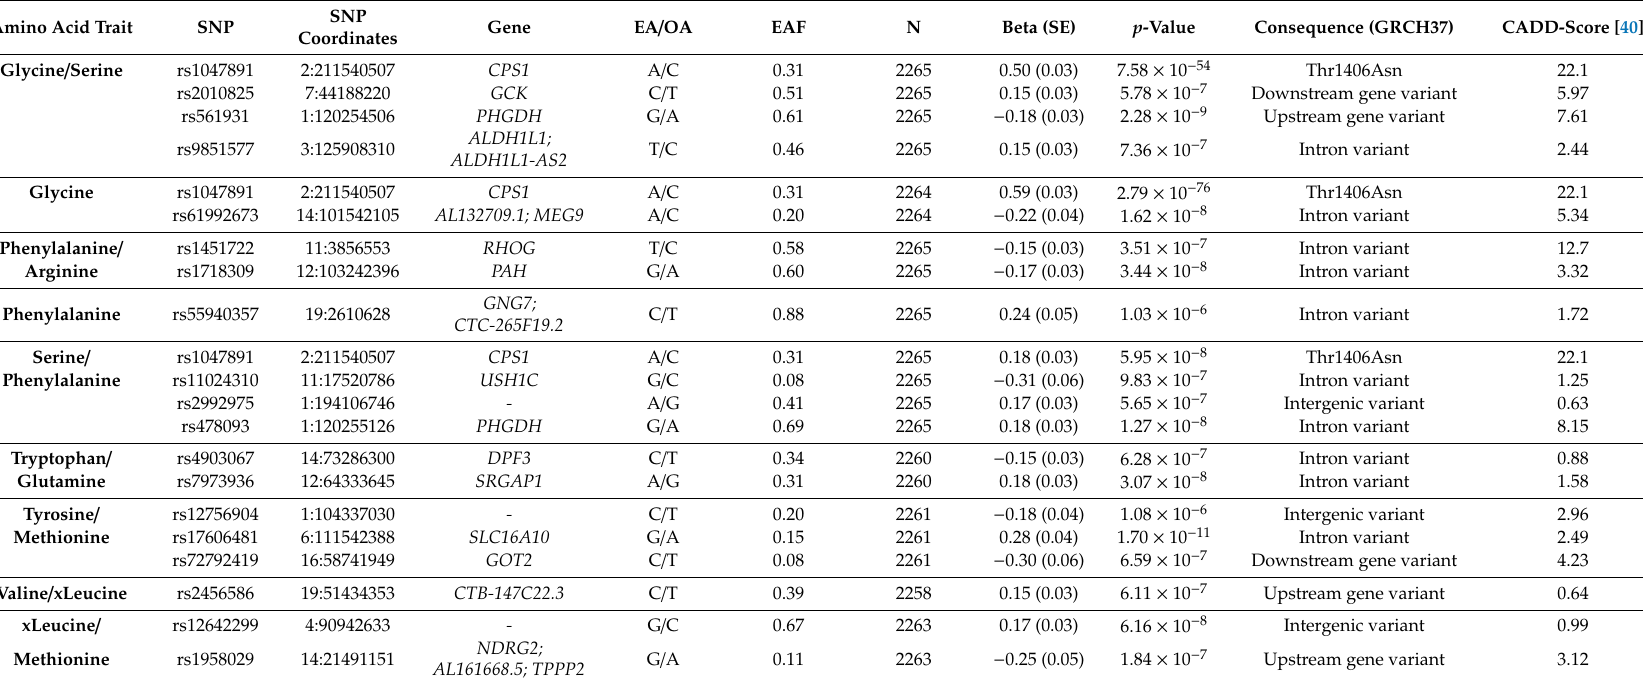
Table 2. Independent GWAS hits at suggestive significance p < 1.11 × 10 − 6 per amino acid trait in